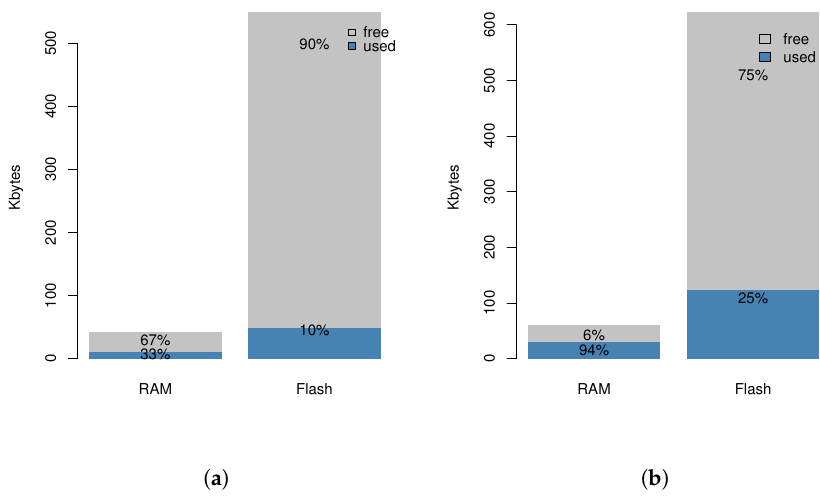
Figure 14. RAM and Flash memory usage in the Zolertia RE-Motes and the Zolertia Orion router. ( a ) Memory average usage in the sketches of the Zolertia RE-Motes; ( b ) Memory usage in the sketch of the Zolertia Orion